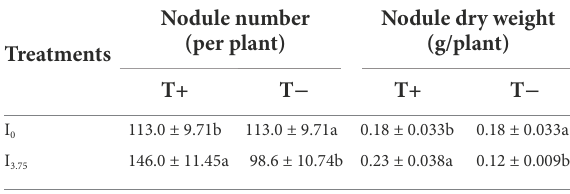
TABLE 4 Effects of unilateral application of isoflavones on double- rooted soybean nodules.